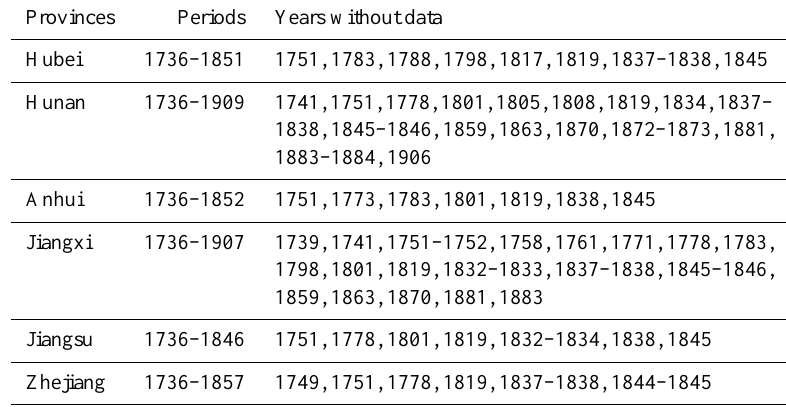
Table 1. Yu-Xue-Fen-Cun information for the MLRYR.